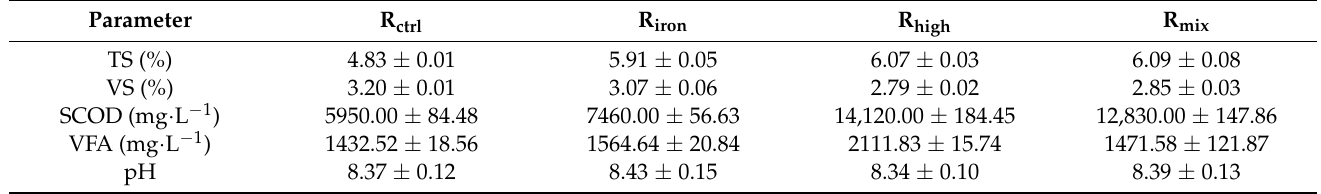
Table 2. Physicochemical properties of sludge after anaerobic